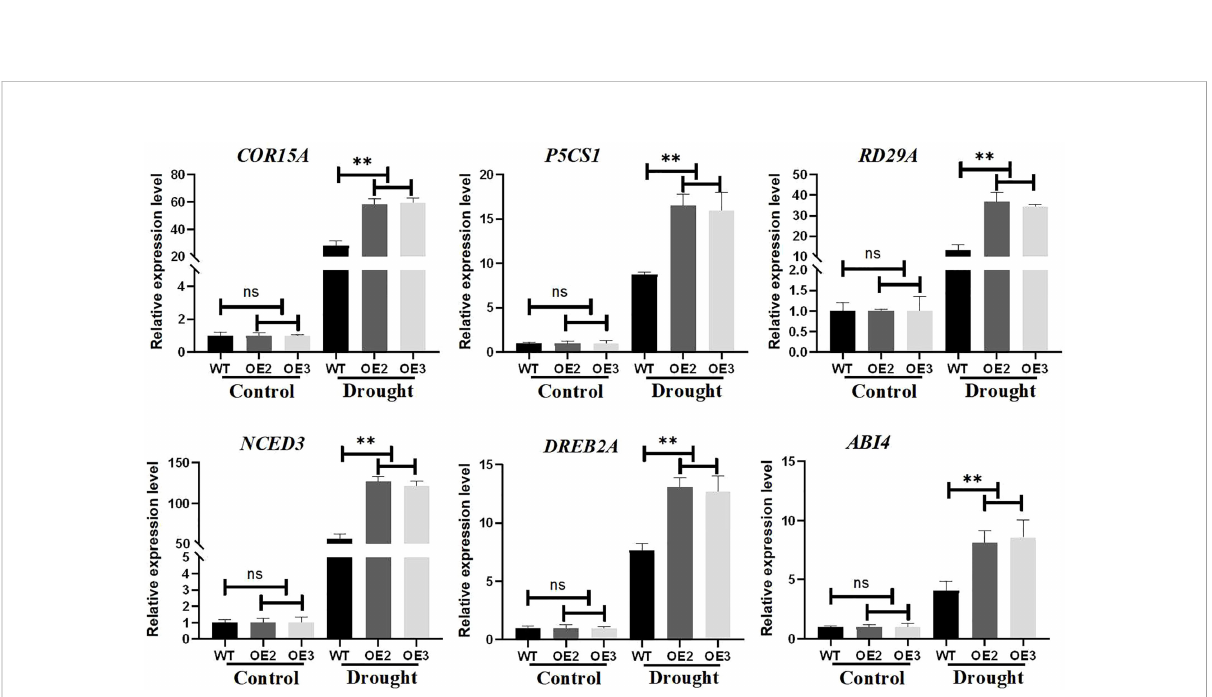
FIGURE 11 Expression levels of drought-stress-related genes in ZmLBD2 transgenic Arabidopsis. Total RNA was isolated from 15-day-old seedlings grown without (CK) or drought treatment for 10 days. Transcript levels of COR15A, P5CS1, RD29A, NCED3, DREB2A, and ABI4 in the transgenic lines and wild type were determined by qPCR AtACTIN8 as reference genes. Fold change was calculated by 2 − DD CT . The ** represents p < 0.01, respectively. Non-signi fi cant